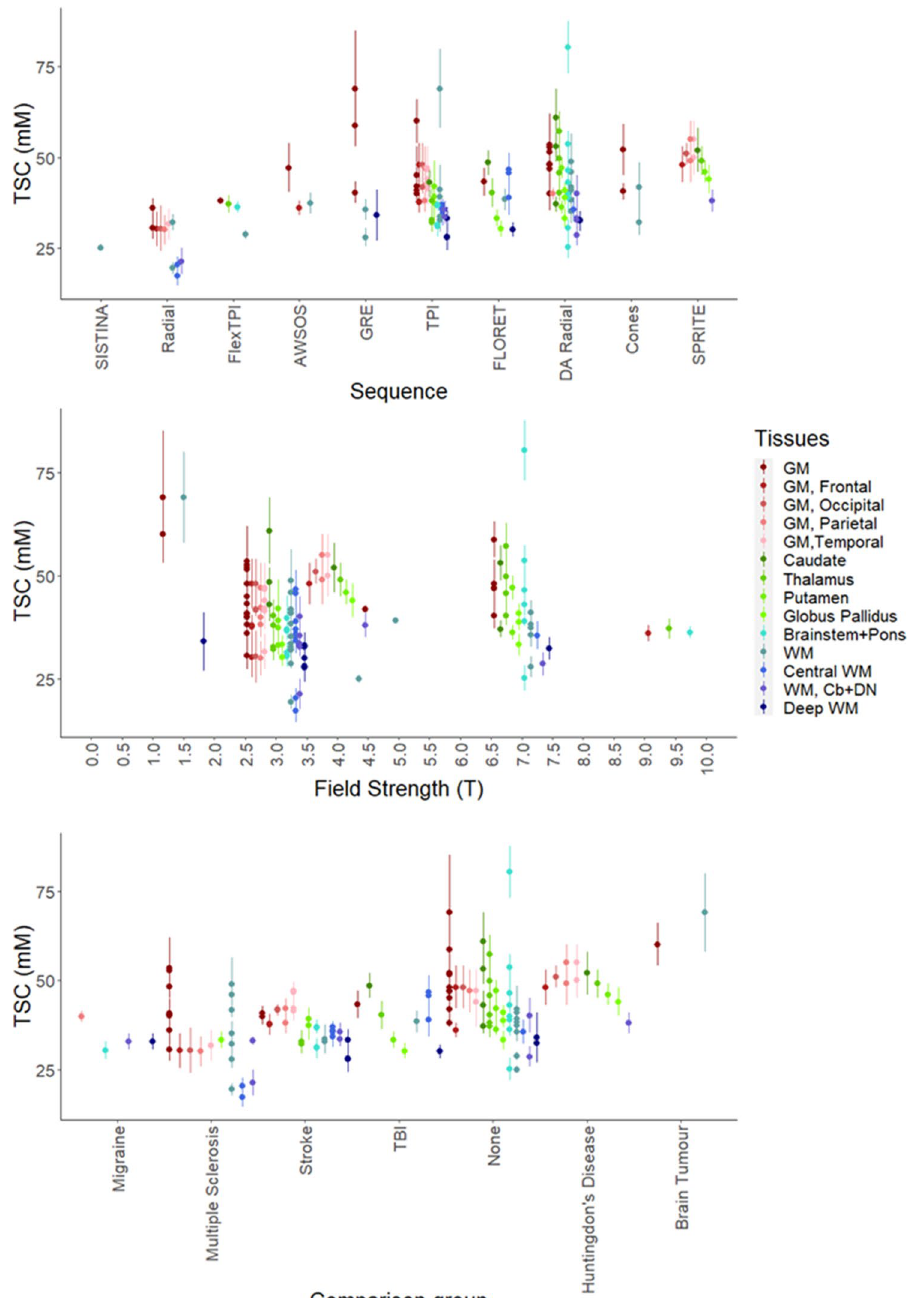
Figure 6. Scatterplot of 141 effect sizes used in meta-analysis ordered by moderators with a mean effect on TSC between levels independent of Tissue. Error bars correspond to standard deviation, except for Zaaraoui et al. 2012 (DA Radial, 3 Tesla, Multiple Sclerosis) who reported range and Driver et al. 2019 (TPI, 4.7 Tesla, None) who reported standard error. Cb, cerebellum, DN dentate nucleus, GM grey matter, WM white matter. Images created in R 84–86